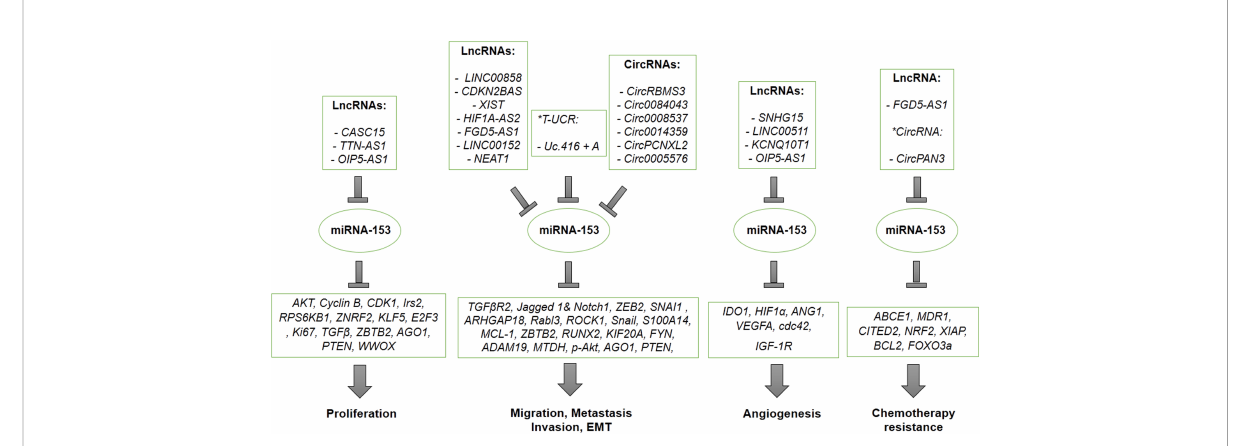
FIGURE 7 A summary fi gure for lncRNA-related regulation of miR-153 and an overall schematic representation of miR153 in